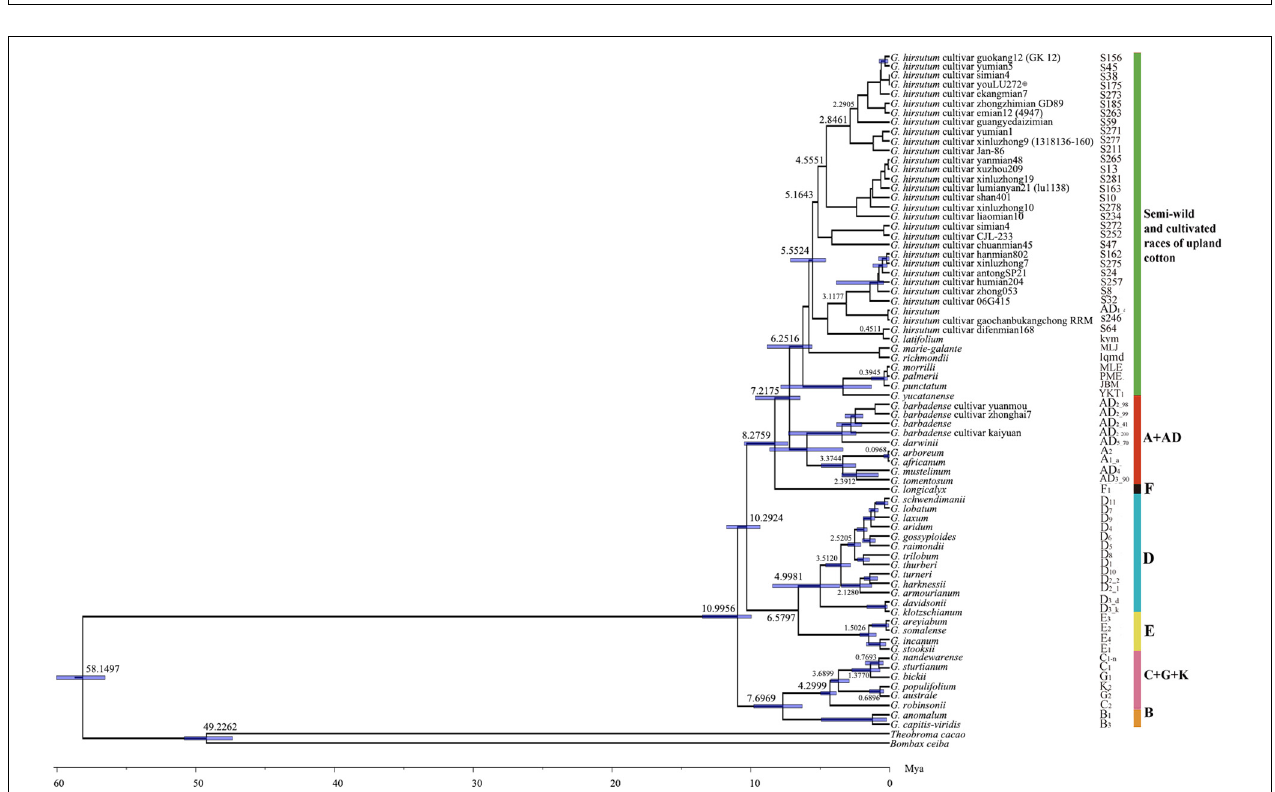
FIGURE 2 | Divergence time tree obtained for cotton accessions based on 72 chloroplast protein-coding sequences.